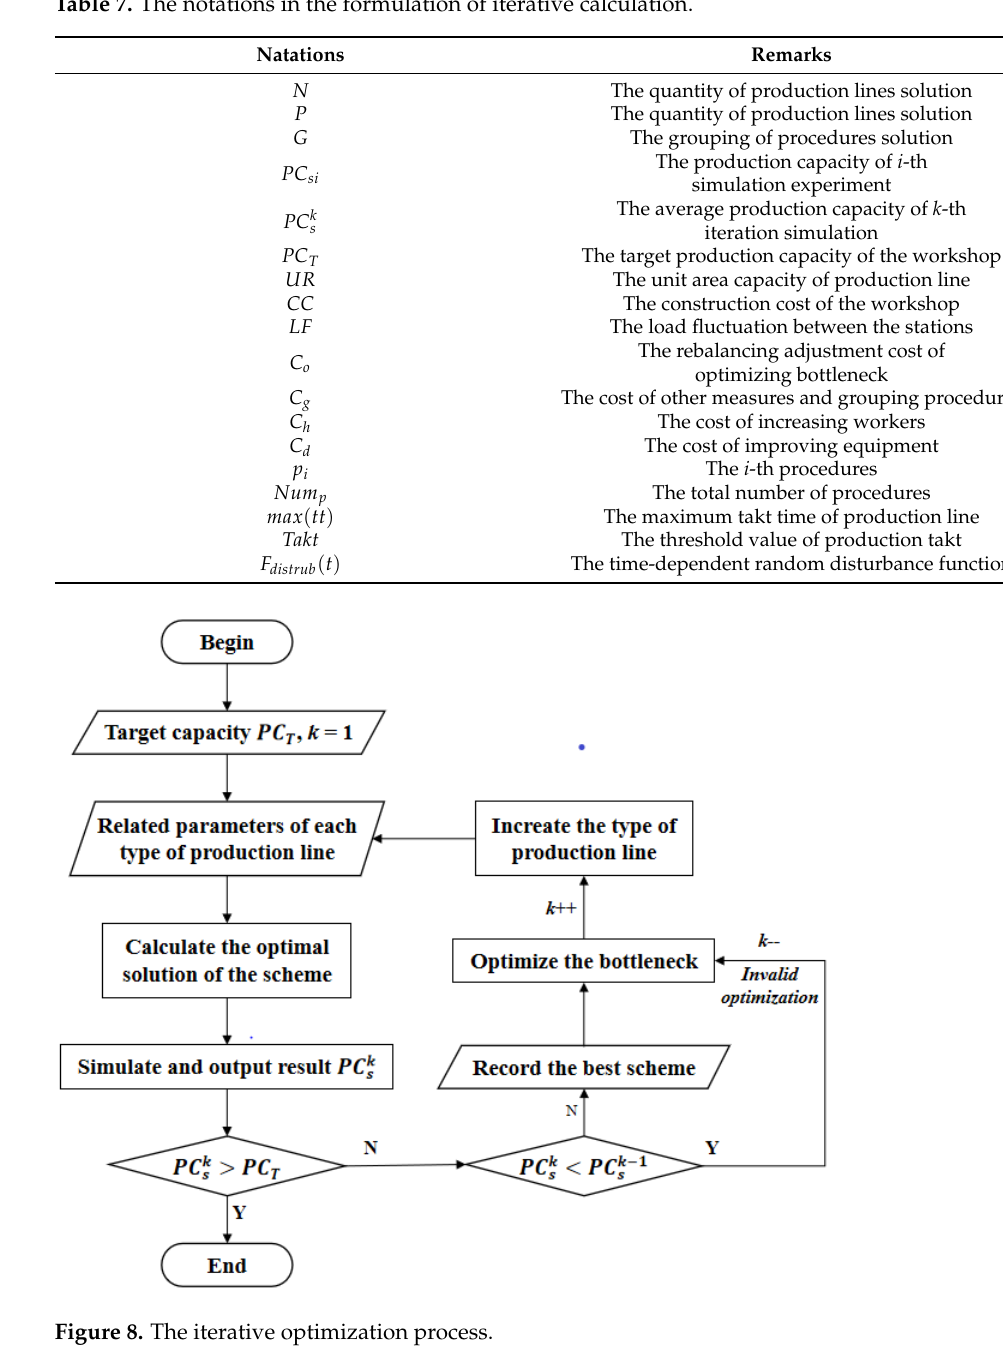
Table 7. The notations in the formulation of iterative calculation.